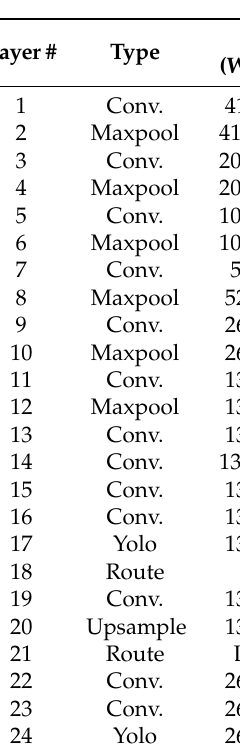
Figure 1. Tiny YOLOv3 layer diagram. Table 1 details the sequence of layers with regards to the input, output, and kernel sizes and the activation function used in each convolutional layer. Most of the convolutional layers perform feature extraction. This network uses pooling layers to reduce the feature map resolution. Table 1. Tiny-YOLOv3